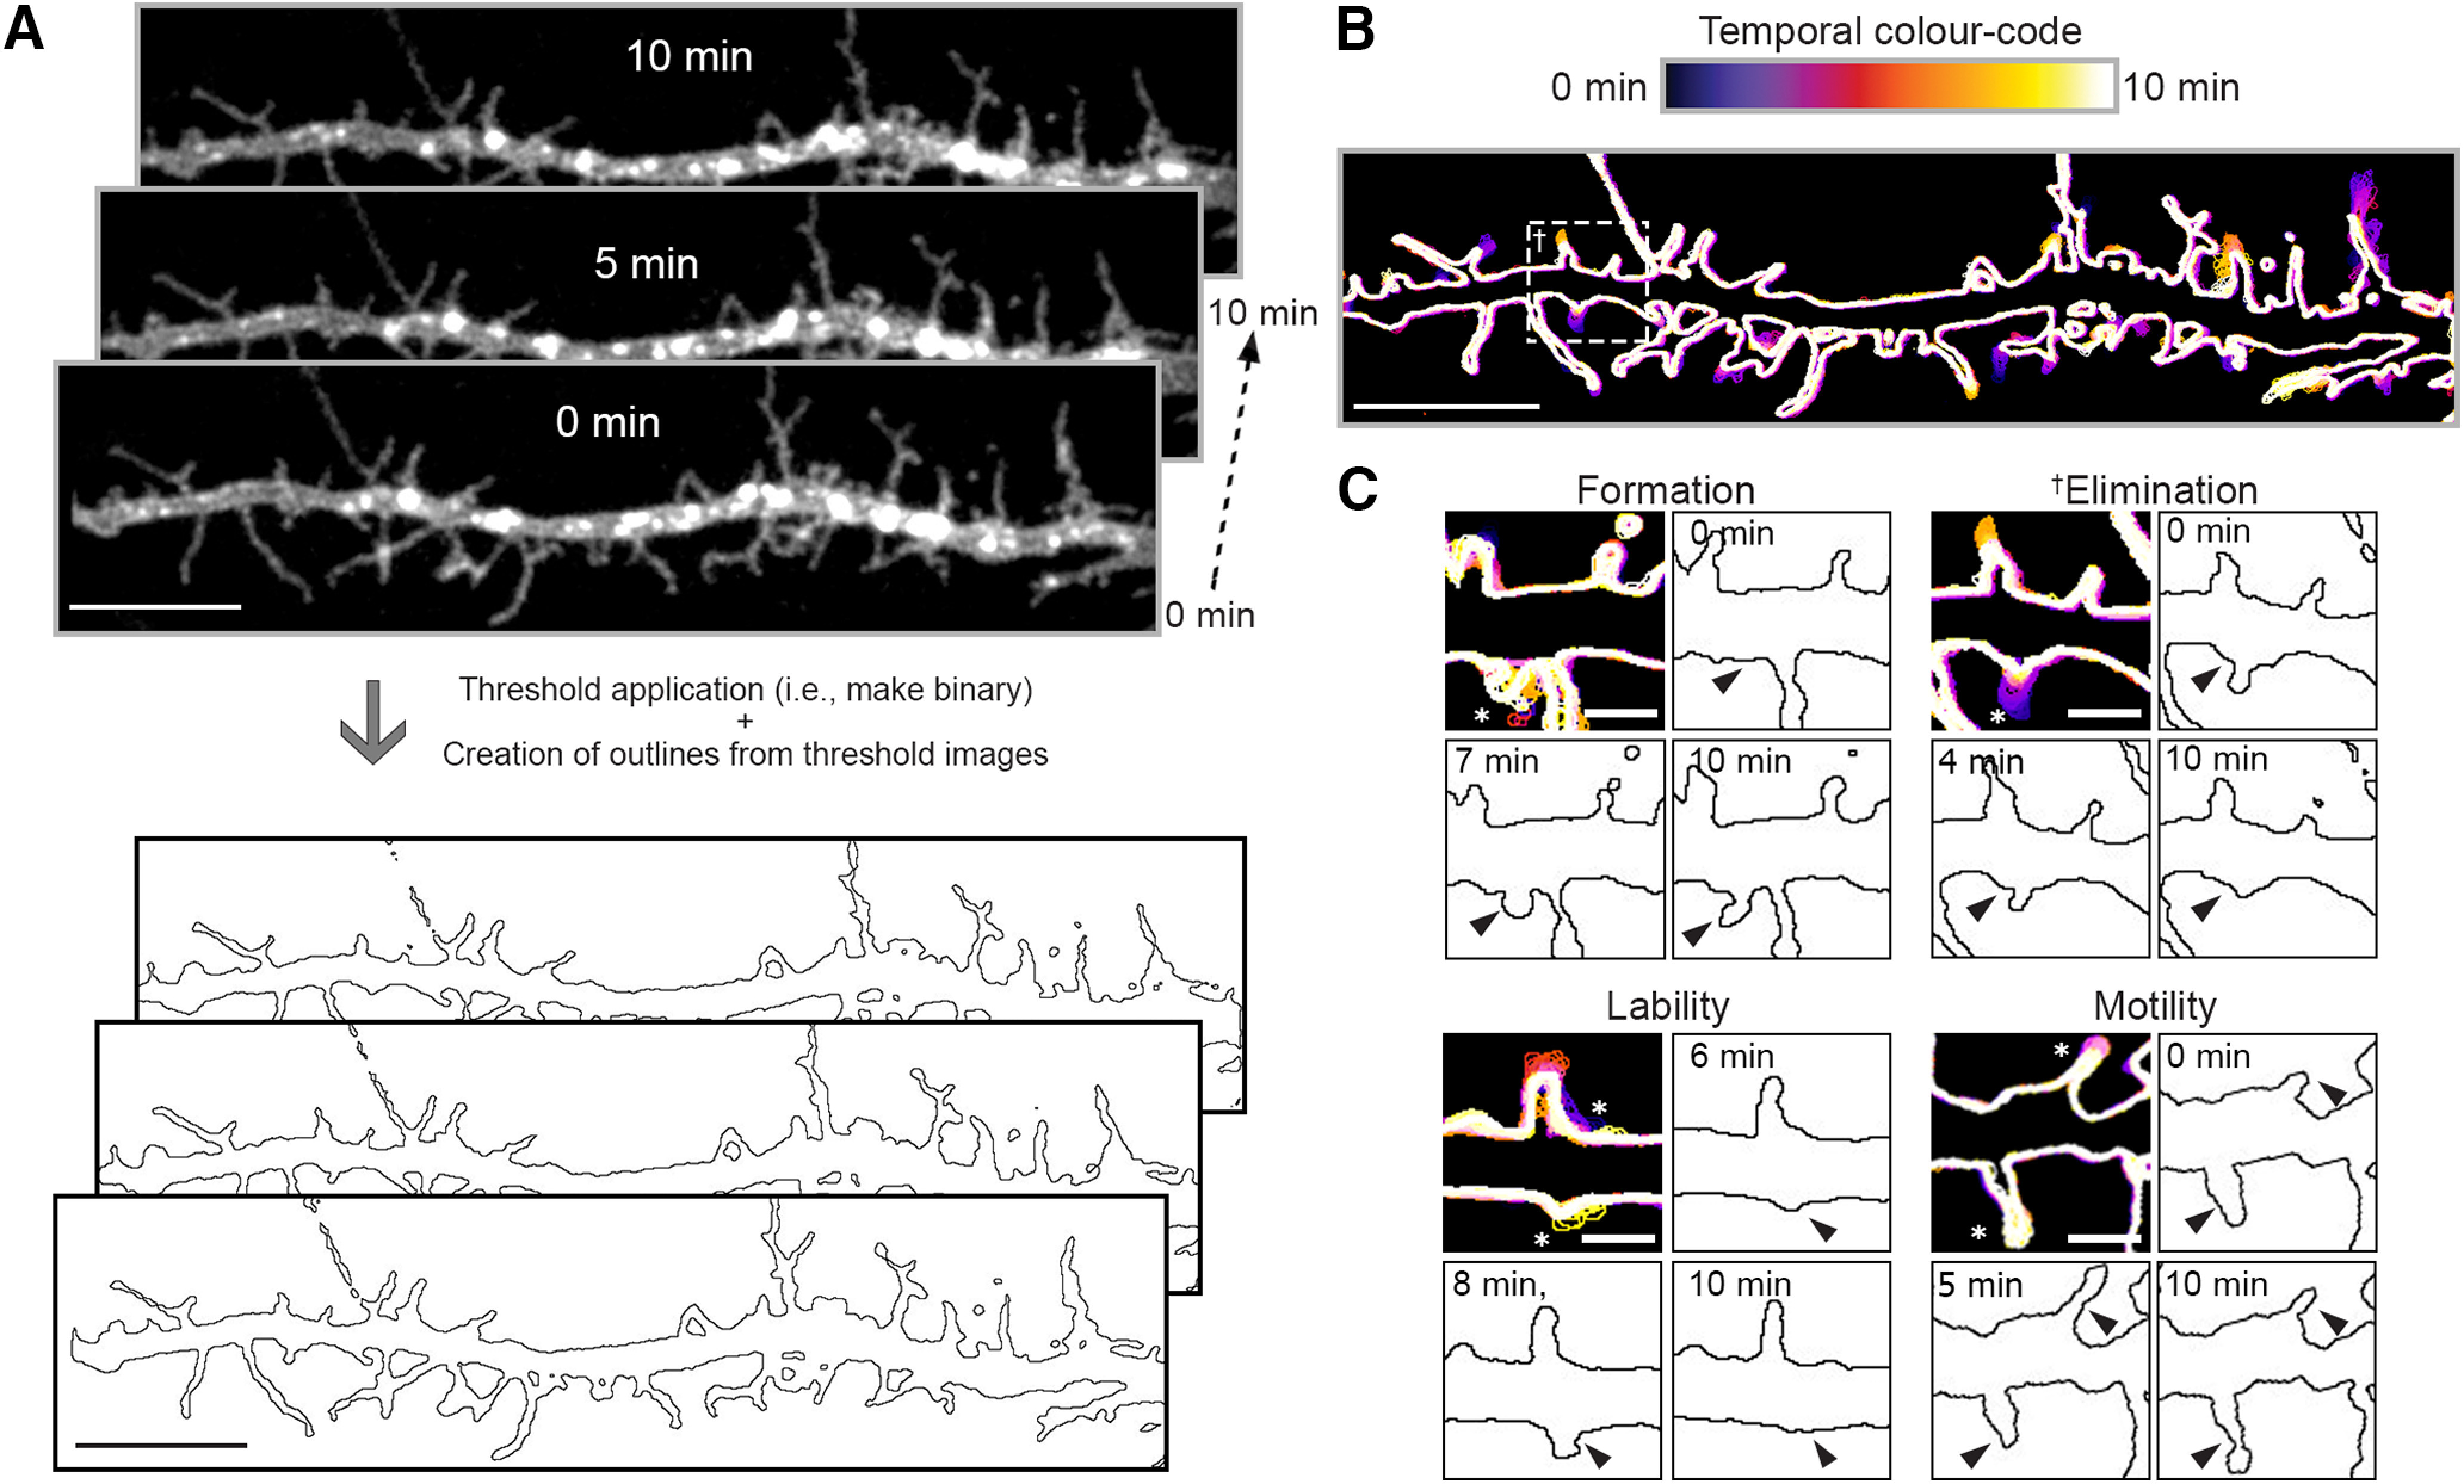
Novel methods for measurement of dendritic protrusion dynamics in living neurons. Ten-minute time lapses were acquired by imaging dendrite segments from cortical neurons every 5 s. Note that this a DIV10 WT cortical neuron transfected with mCherry-CD9-10 and PANX1-EGFP; only mCherry-CD9-10 is shown. The dimensionality of these recordings was reduced by creating maximum z-projections. Images were thresholded to create outlines (A; scale bar: 10 µm), which were temporally color coded (B; scale bar: 10 µm), allowing the visualization of various events, such as the percentage of dendritic protrusion (relative to time 0) undergoing formation (de novo appearance), elimination (complete disappearance by the end of the time lapse), lability (appearance and disappearance by the end of the time lapse), and motility (incomplete shrinkage or growth to an existing protrusion) shown in C (scale bar: 2 µm). Note that examples in C (cropped to highlight the event in question with (*) denoting the protrusion events) come from different cultures and different genotypes all at DIV10 transfected with mCherry-CD9-10 and either EGFP or Panx1-EGFP at DIV6. Note that the example provided here for dendritic protrusion elimination (†) in the box in part C comes from the larger neurite depicted in panel B. Also note that the data shown in Figure 4 includes quantification from the examples depicted in this figure. For further details, see Materials and Methods. This figure was modified from the PhD thesis of J.C.S.-A, University of Victoria (Sanchez-Arias, 2020), found at http://hdl.handle.net/1828/11714.